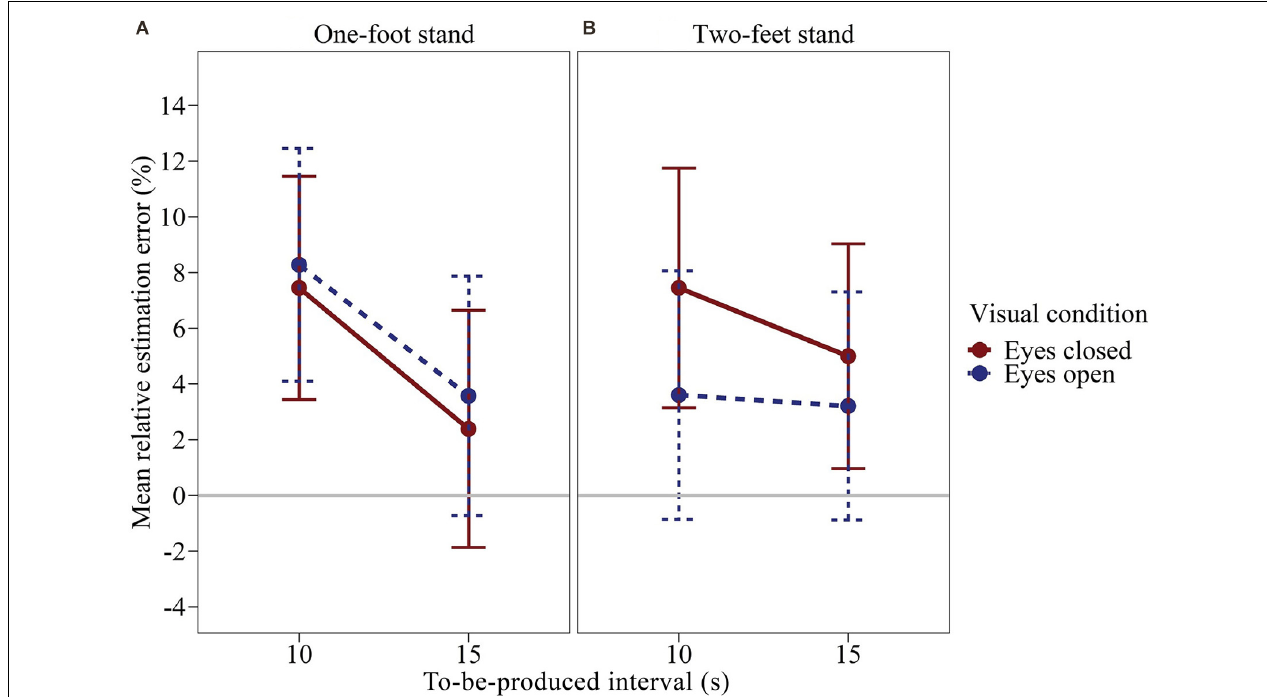
FIGURE 2 | Mean relative estimation error of to-be-produced intervals by visual condition for each balance condition of Experiment 1. (A) One-foot stand condition, (B) two-feet stand condition. Error bars represent ± 1 standard error of the mean (SEM). Values above 0 indicate relative overproduction of the